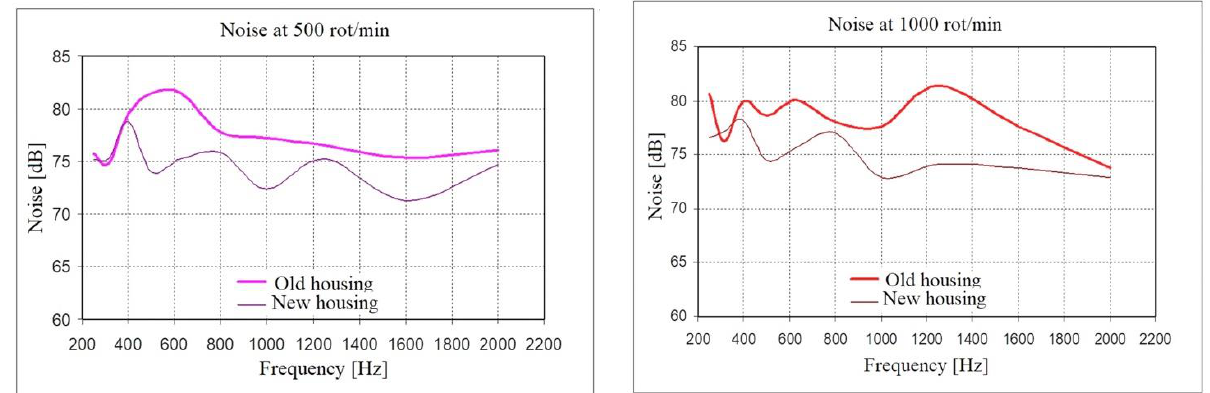
Figure 36. Lp sound pressure level diagrams for right side surface at 500 and 1000 rpm.